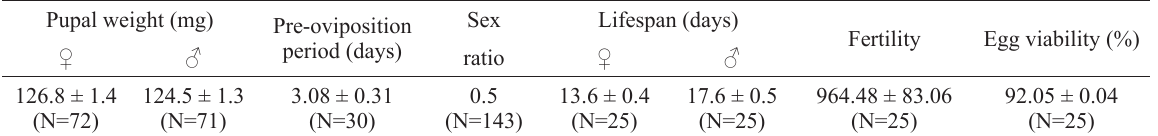
Condylorrhiza vestigialis pupal weight, pre-oviposition period, sex ratio, lifespan of females and males, fertility, and mean egg viability observed on Diet 3 (corn, wheat germ and